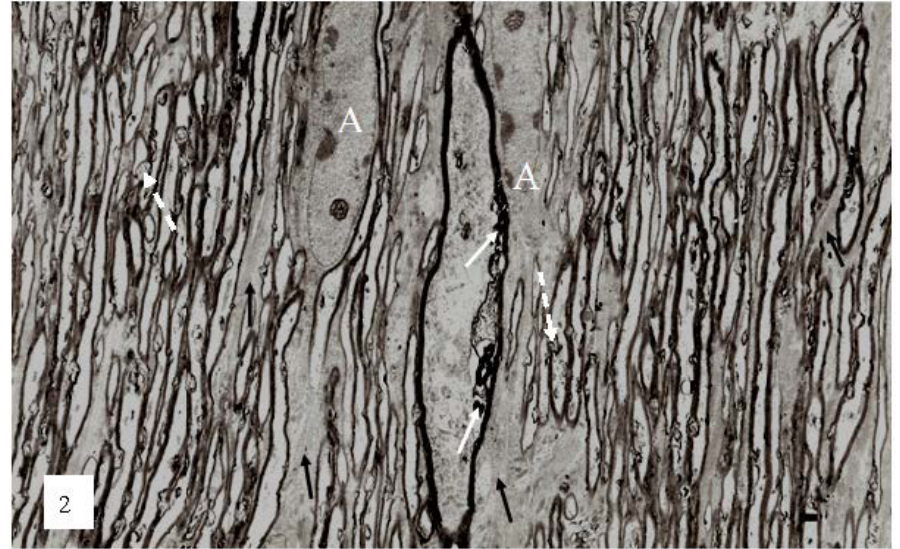
Figure 2. A low magnification, longitudinal plane field of a resin embedded thin section of optic nerve at 2 h after an acute stretch-injury (19–22 ms period of mechanical loading). Two astrocyte cell bodies (A) are visible. Bundles of astrocyte intermediate filaments (GFAP) (arrow) occur within astrocyte processes (black arrows) extending between myelinated nerve fibres. A large, damaged nerve fibre with a lucent axoplasm and numerous irregular myelin discontinuities (md—white arrows) is visible in the centre of this field. Closer examination of the field reveals numerous lucent and dark md in the myelin sheaths of neighboring, smaller nerve fibers (dotted white arrows). Magnification 2300×.